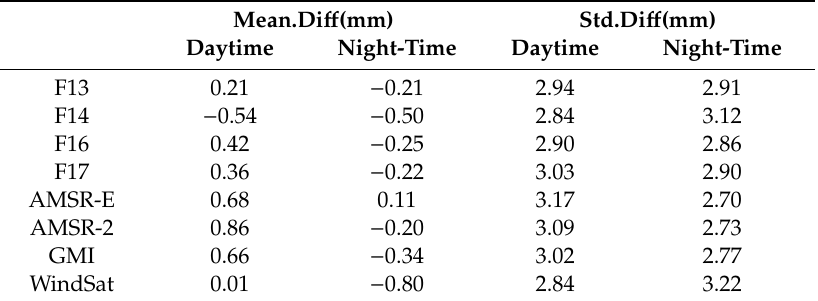
Table 2. Summary statistics of TPW di ff erence for each satellite during day and